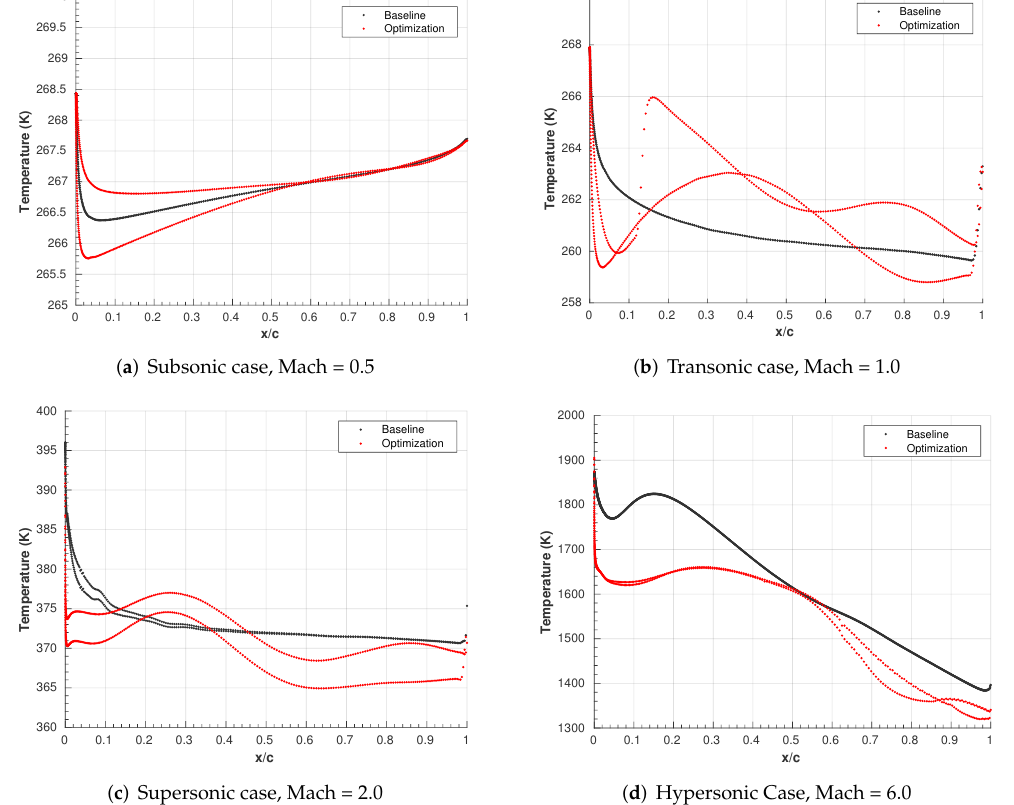
Figure 12. Comparison between baseline and optimized temperature distributions. ( a ) Subsonic case, Mach = 0.5. ( b ) Transonic case, Mach = 1.0. ( c ) Supersonic case, Mach = 2.0. ( d ) Hypersonic case, Mach =